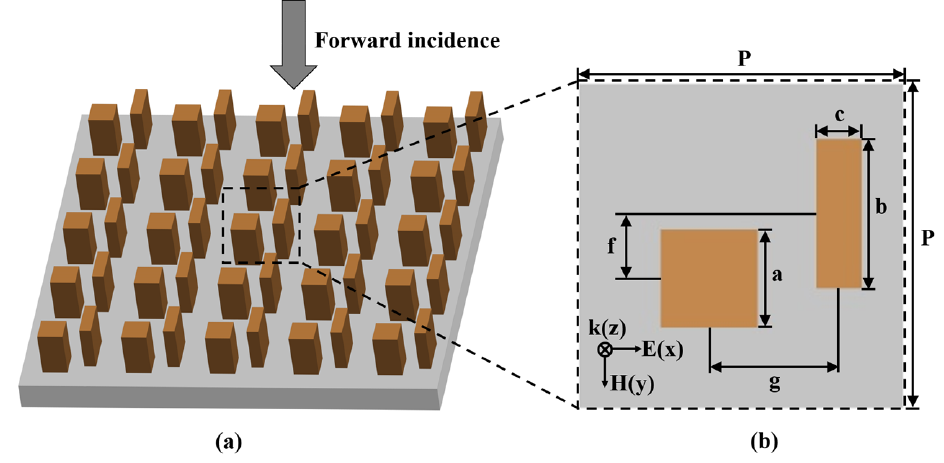
Figure 1. ( a ) Schematic of the near-infrared bidirectional EIT metasurface based on a-Si cuboid-bar nanostructure periodic arrays on the SiO 2 substrate. The black dash box shows a unit cell. ( b ) Top view of the unit cell.